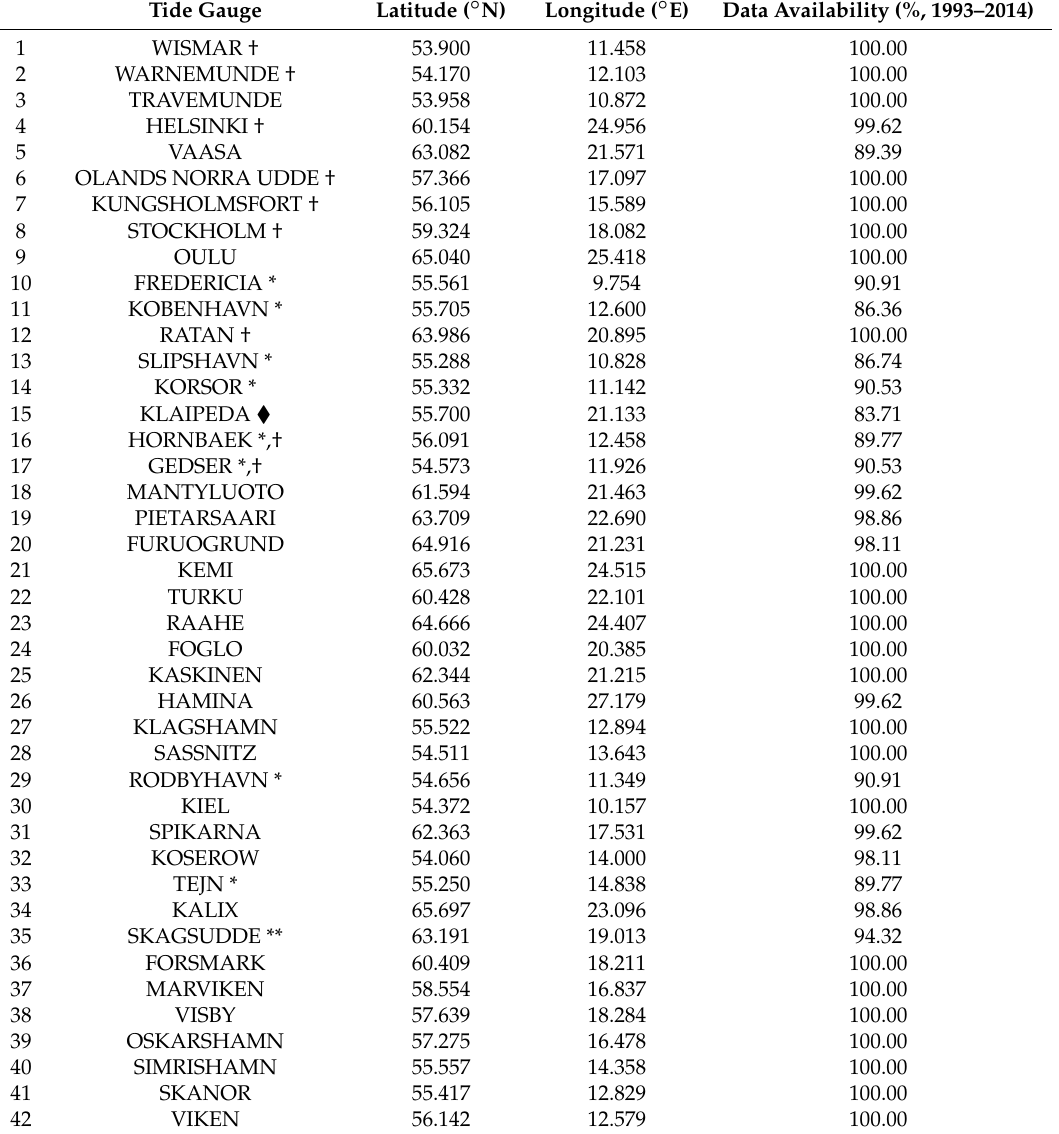
Table 1. Tide gauge information used in the present study. ( (cid:7) Data valid during 1993–2011. * Data valid during 1993–2012. ** Data valid during 1994–2014. † Data valid during